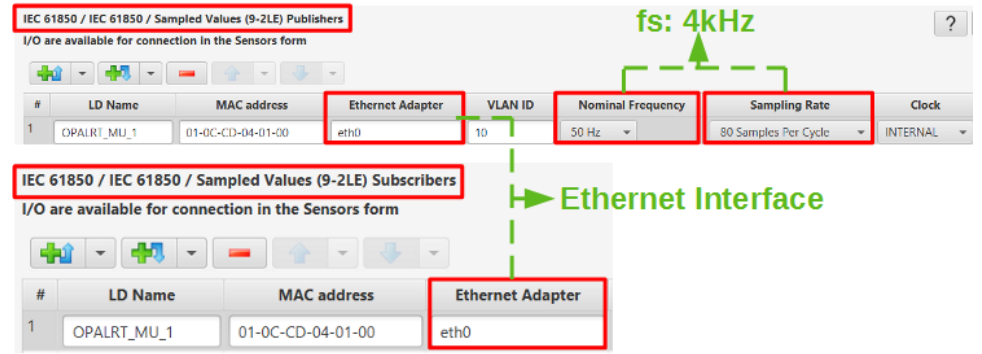
Figure 20. Inbuilt communication protocols.